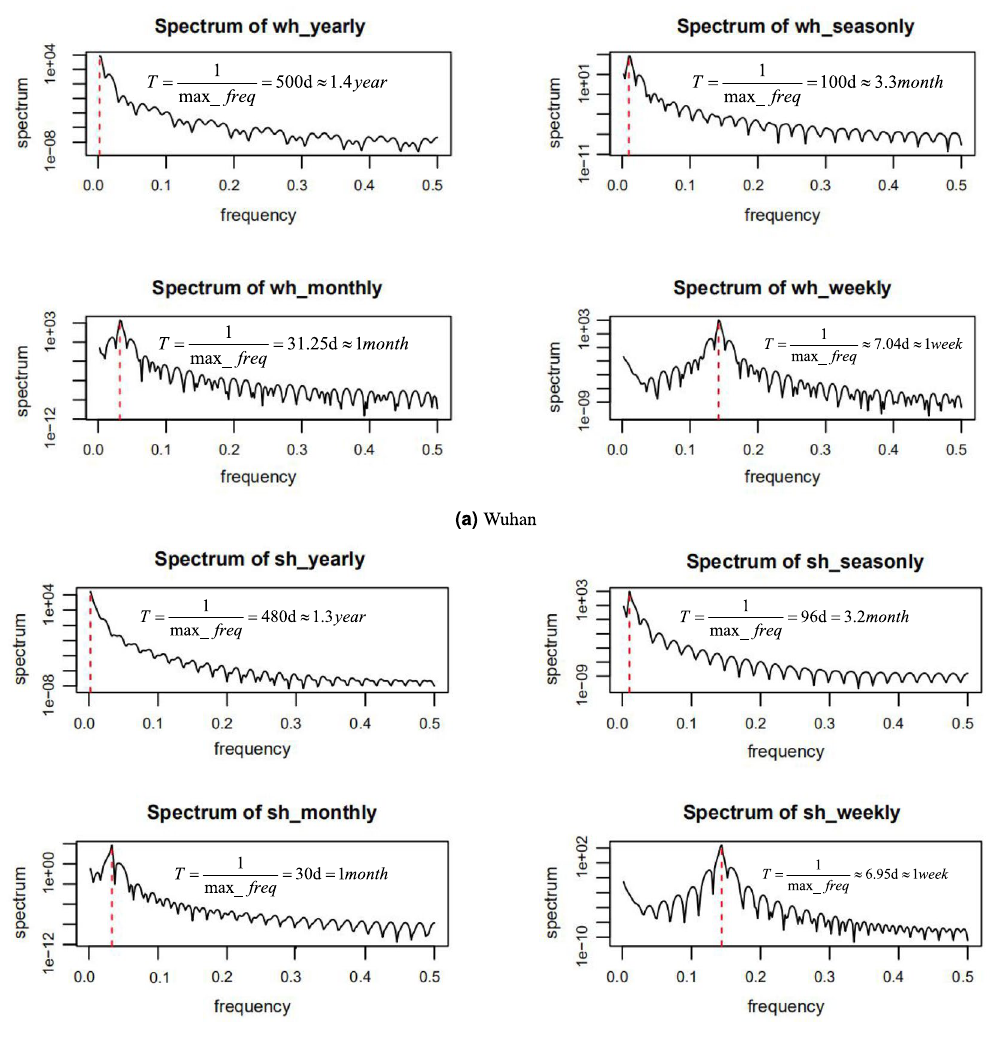
Figure 5. The spectrum of the yearly, seasonly, monthly, and weekly series of Wuhan and Shanghai.